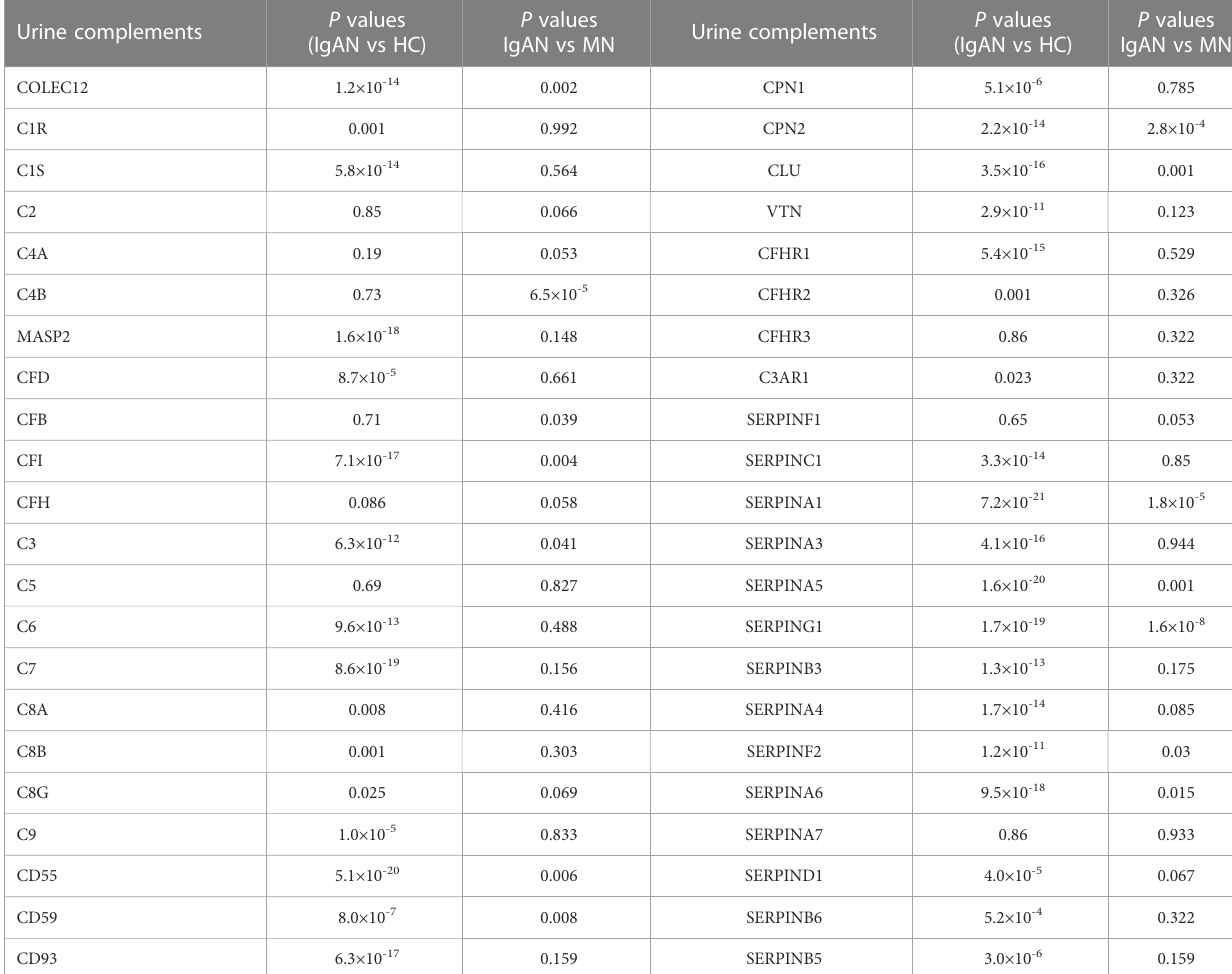
TABLE 2 Comparisons of urinary complement proteins between IgAN patients and HC or MN patients, respectively.